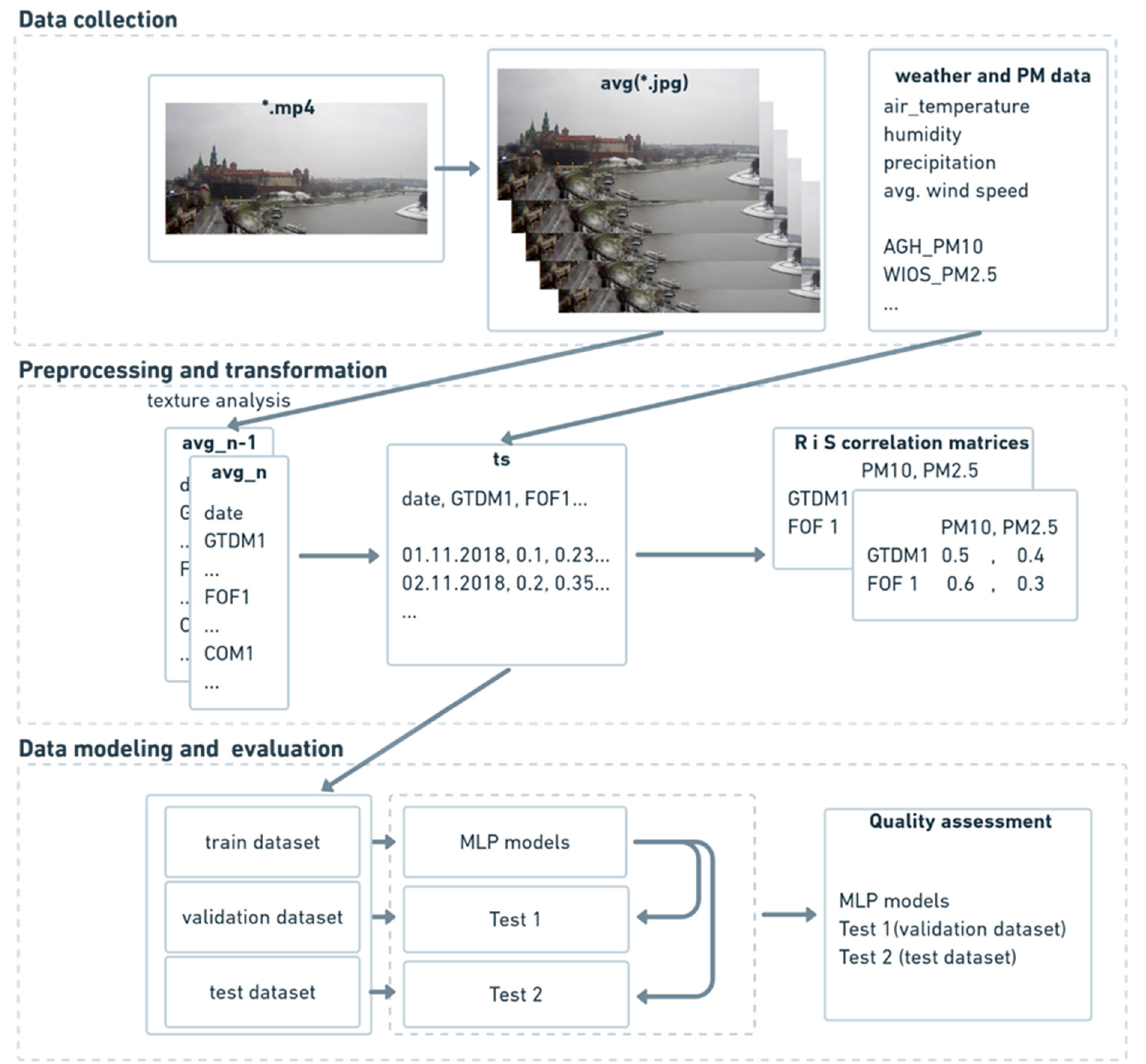
Figure 4. Block diagram of the proposed method.